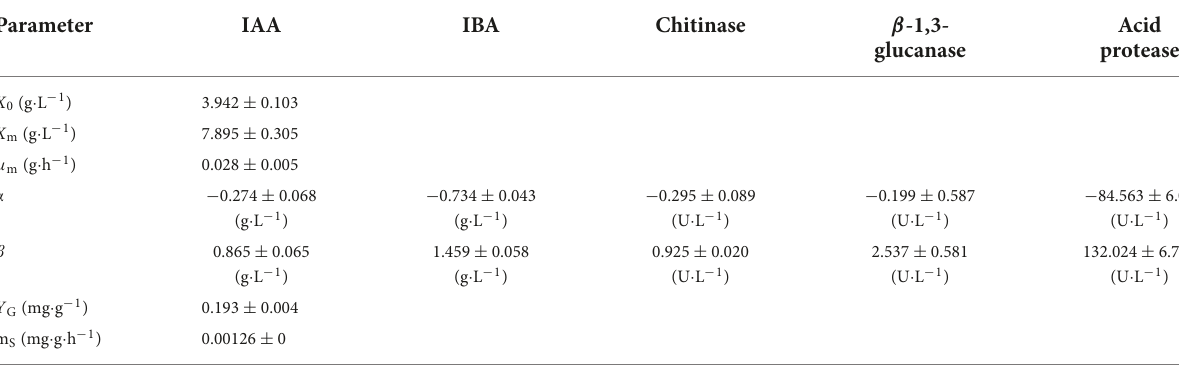
TABLE 4 Kinetic parameters for bioreactor